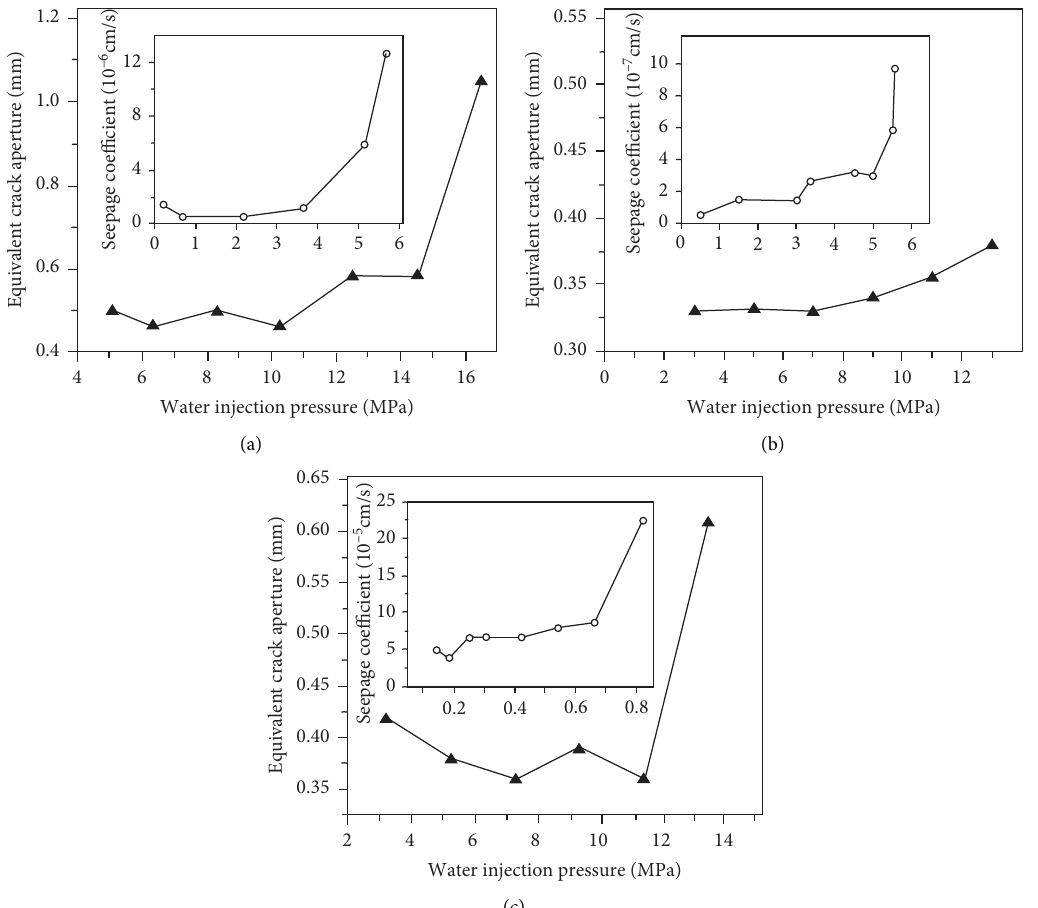
Figure 3: In situ water pumping tests on the fractured rock mass. (a) Normal fault; (b) reverse fault; (c) unloading disturbance zone.